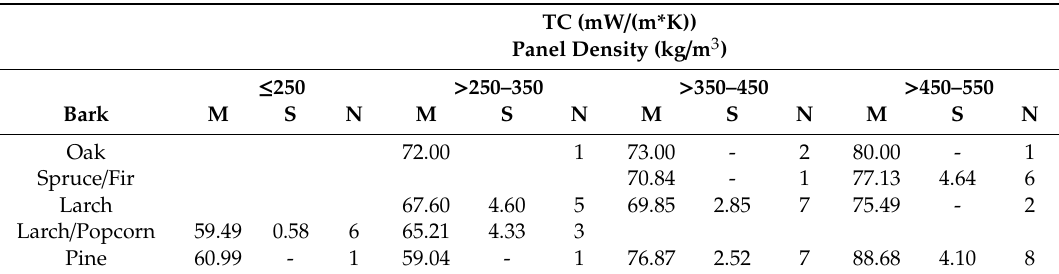
Table 9. TC according to density class and bark